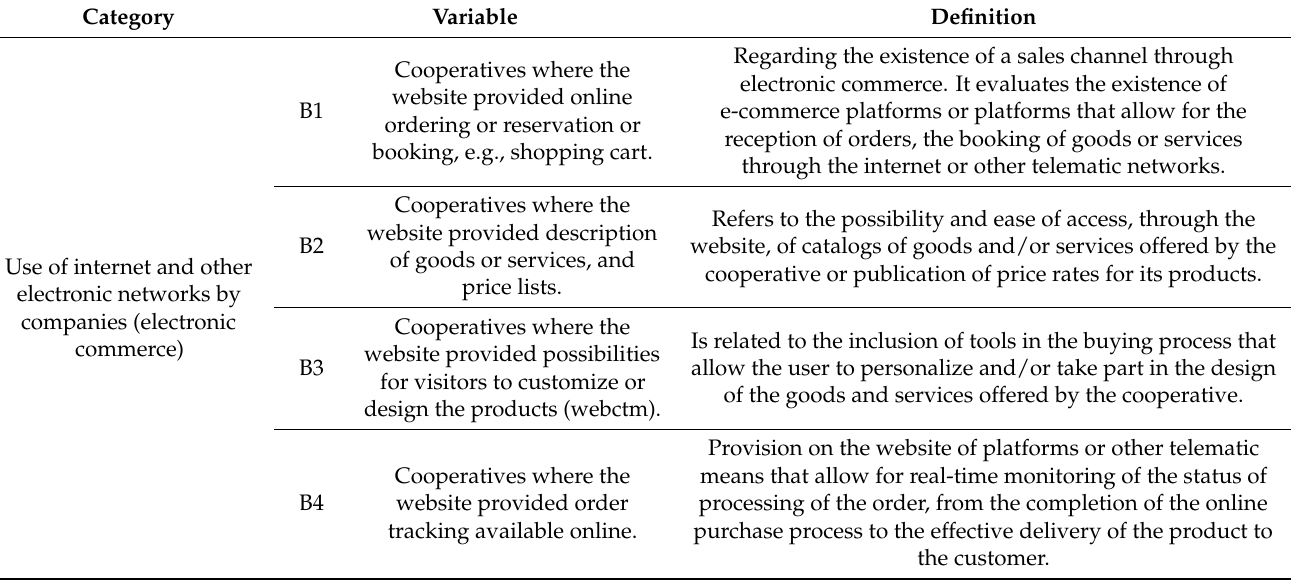
Table 2. Services offered on the internet and electronic commerce: selected variables. Source: own development based on the “Community survey on ICT usage and e-commerce in enterprises” (Eurostat, several years) and [28]. Category